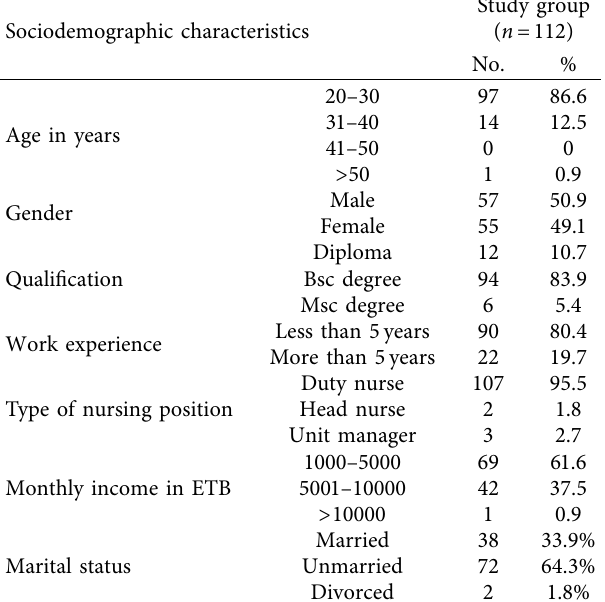
Table 1: Personal and professional characteristics of nurses working in the adult ICU at federally administered hospitals in Addis Ababa, 2019 ( n �